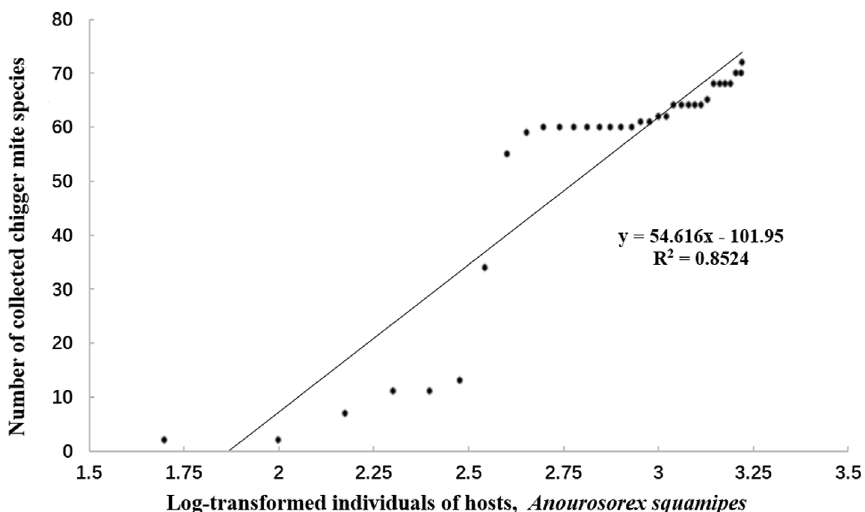
Figure 5. The species-sample relationship of chiggers on Anourosorex squamipes shrews between the log-transformed host individuals (shrews) and the number of the chigger species in Southwest China (2001 –